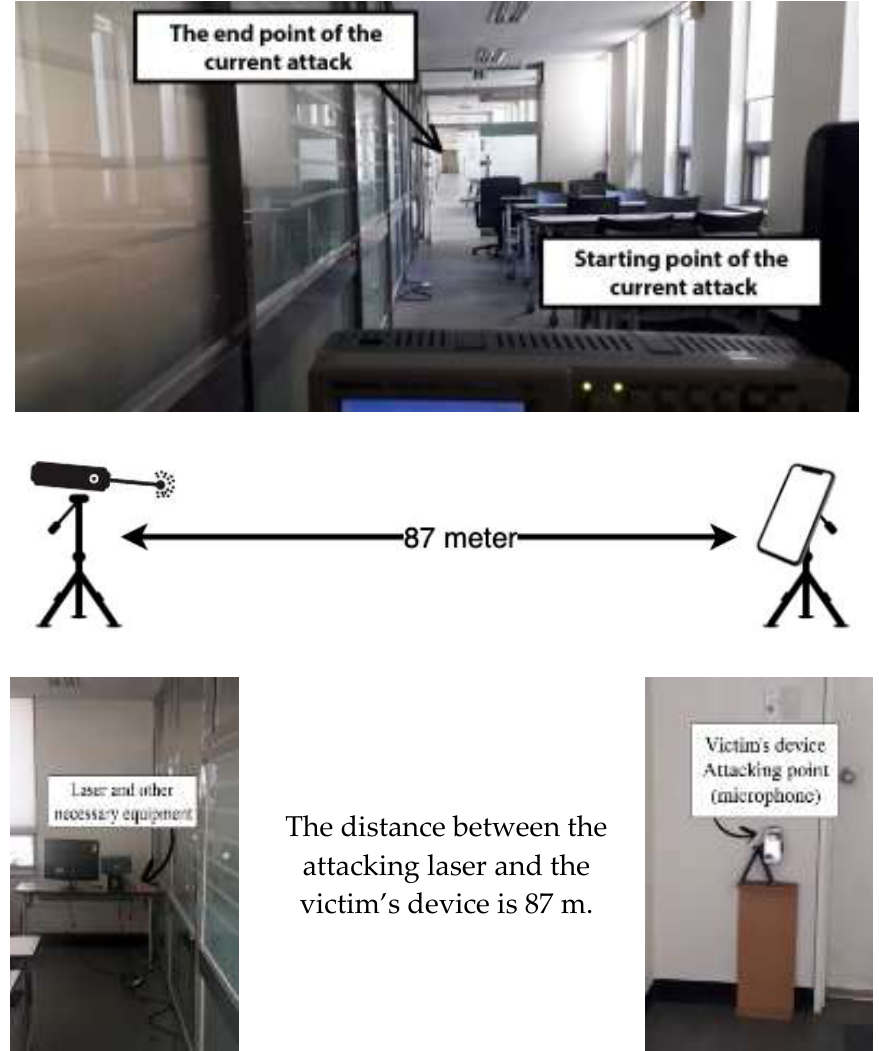
Figure 4. Experimental configuration for investigating attack range.